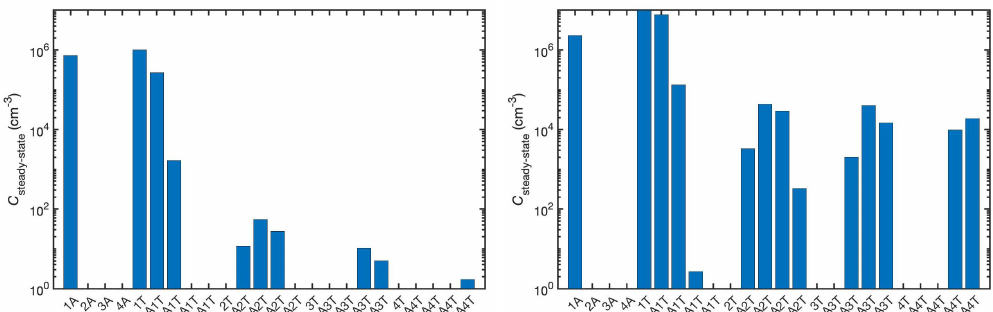
Figure 6. Steady-state cluster distributions for SA–TMAO clusters at 298.15 K and vapor concentrations of [SA] = 10 6 cm − 3 and [TMAO] = 10 6 cm − 3 ( left ) and [SA] = 10 7 cm − 3 and [TMAO] = 10 7 cm − 3 ( right ). Here A refers to sulfuric acid and T is trimethylamine